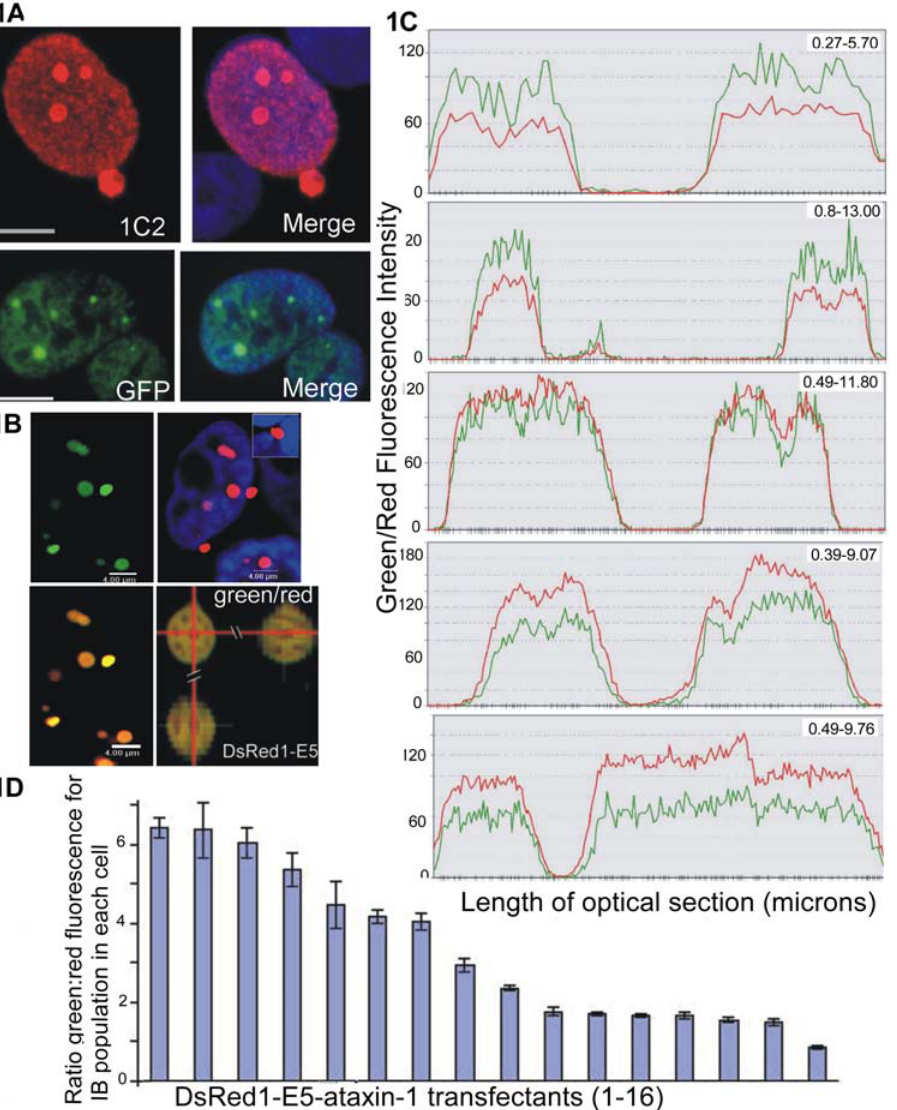
Figure 1. Expression patterns of ataxin-1 fusion proteins. Figure 1A. Distribution of ataxin-1 and ataxin-1-GFP. Upper panel; untagged ataxin-1 stained with 1C2 with a DAPI merge; lower panel, GFP-ataxin-1 with DAPI merge. Figure 1B. DsRed1-E5-ataxin-1 emits both red (r) and green (g) fluorescence. The merged red green and red/DAPI fluorescence micrographs are also shown. An orthogonal slice through a reticular IB seeded by DsRed1-E5-ataxin is shown lower right. Scale bars: 8 microns. Figure 1C. IBs of DsRed1-E5-ataxin express protein of comparable age. Synchronous peaks and troughs of red/green fluorescence emitted by IBs of DsRed1-E5-ataxin in shared nuclei. IBs are ranked according to maturity; with high g/r ratios indicating immature protein. Figure 1D. Synchronous seeding of DsRed1-E5-ataxin IBs. HeLa nuclei were ranked according to mean g/r ratio of their IB populations (24hr after transfection). 169 IBs in 16 nuclei were included in this data set. doi:10.1371/journal.pone.0001014.g001 DsRed1-E5-ataxin-1 transfectants revealed cells arrayed on a diagonal (Figure 2A, middle panel), with immature green fluorescent DsRed1-E5-ataxin-1 becoming redder (and greener) with increasing time after transfection. Again these cells could be grouped according to increasing fluorescence intensity and each group could be analysed individually for viability. In double transfectants (Figure 2B, RH Panel) the fluorescence signature attributable to DsRed1-E5-ataxin-1 is ablated, and a dominant green fluorescent signature, characteristic of GFP-ataxin-1 evident (Figure 2B, right hand panel). Only a small increase in cell number is seen in the region indicated in the two density plots (Figure 2C).